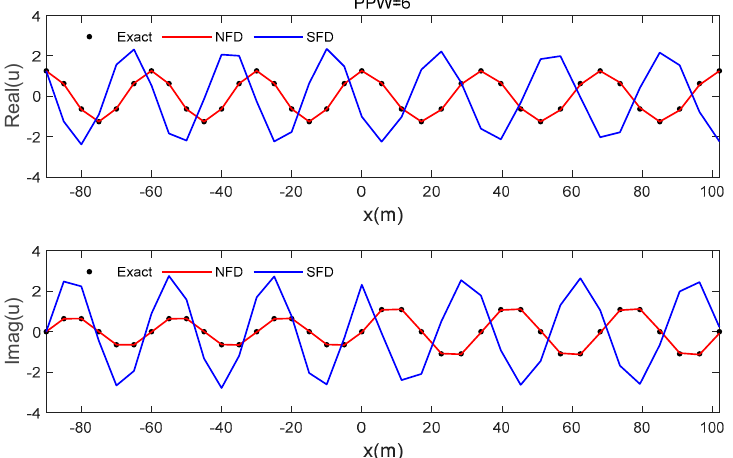
Figure 3. The real and imaginary parts of solutions in the plane-wave reflection case with PPW = 6.